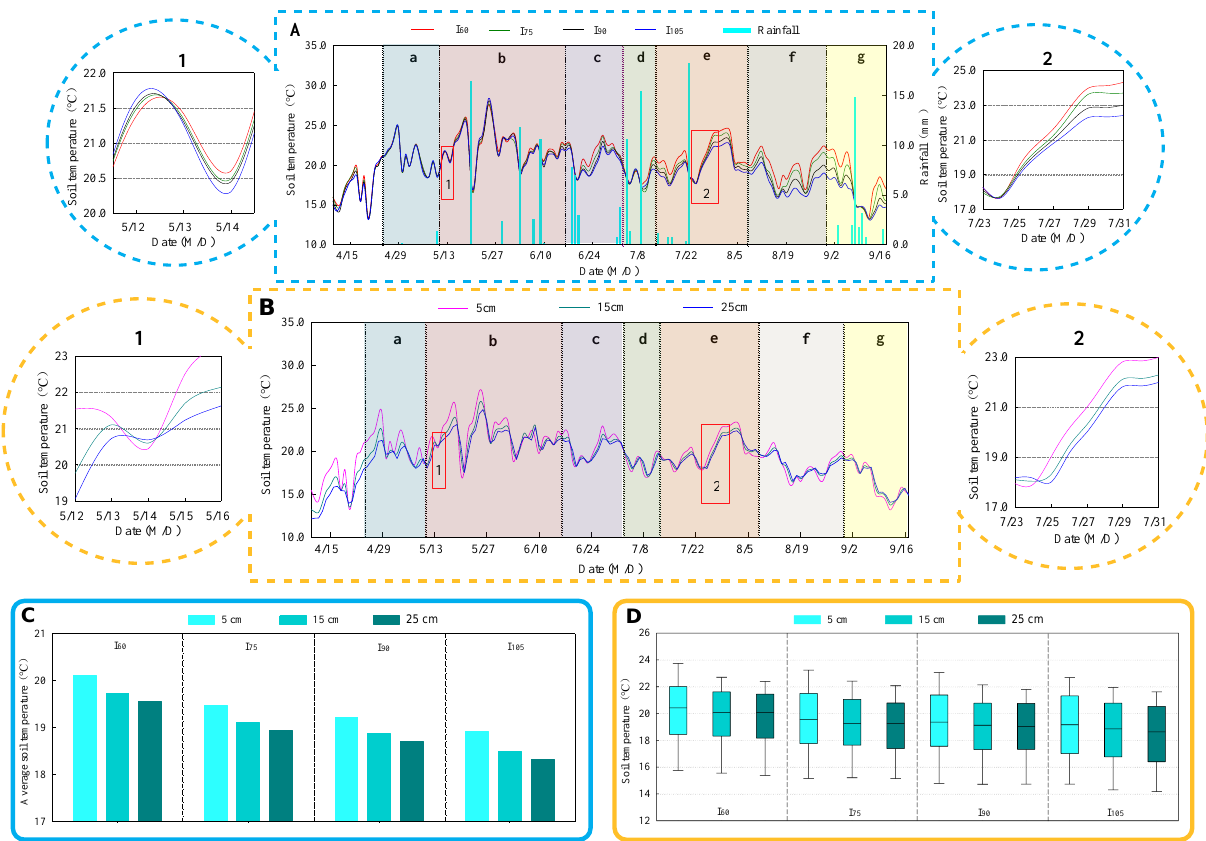
Figure 6. Mean soil temperature and rainfall during the growing season of spring maize in 2015. ( A ) Temperature at 5 cm below soil surface under different irrigation treatments; ( B ) temperature at 5, 15 and 25 cm below the soil surface under I90 treatments; ( C ) average temperature at 5, 15 and 25 cm below the soil surface in different irrigation treatments in 2015; ( D ) the daily average